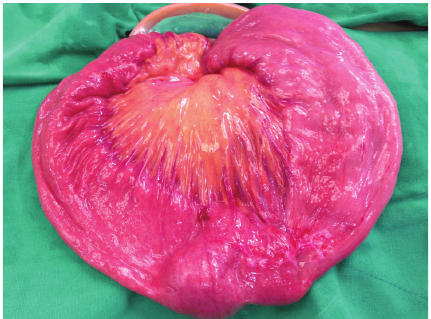
Figure 3: Operative findings. A polypoid mass was detected after reduction of the intussusception in the